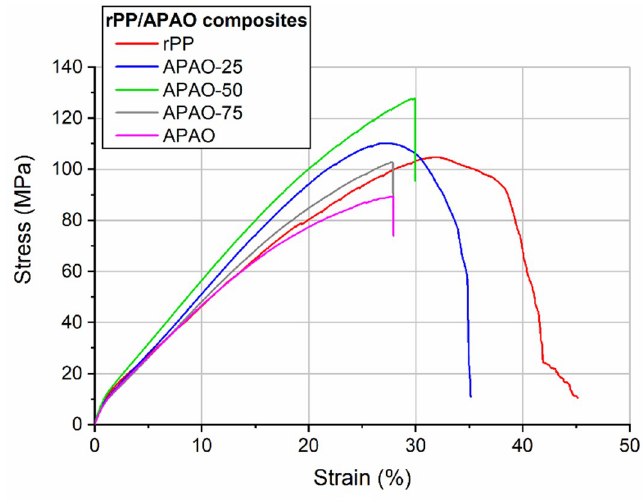
Figure 8. Typical tensile curves of the rPP/APAO composites.